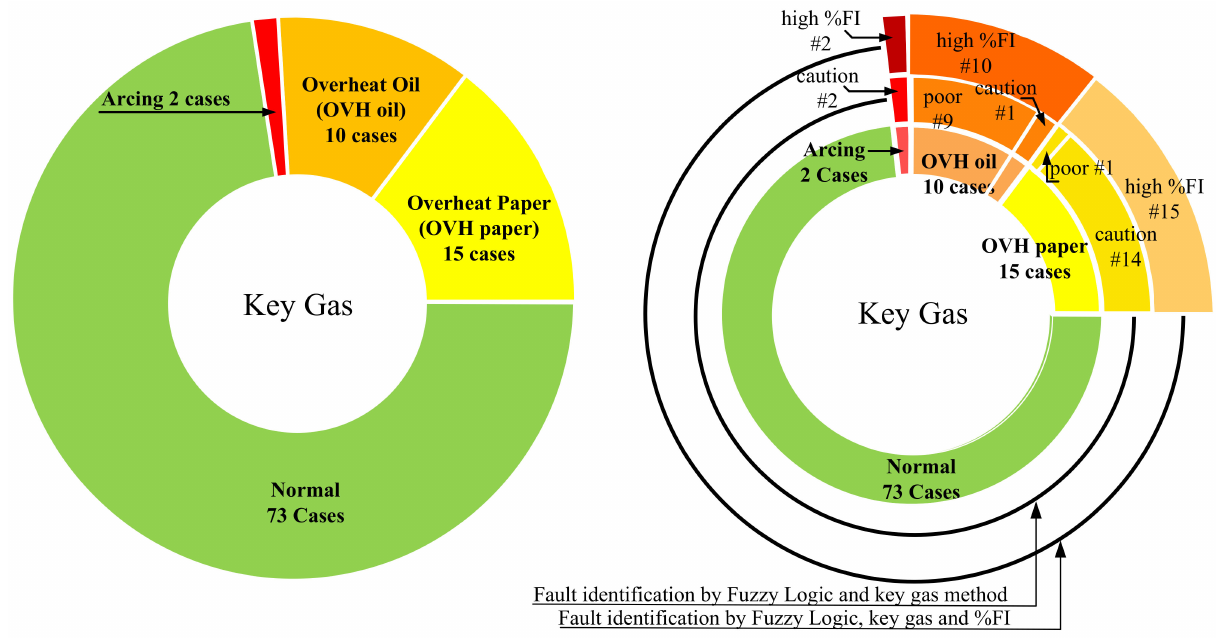
Figure 12. Fault types analyzed by using fuzzy logic with the key gas